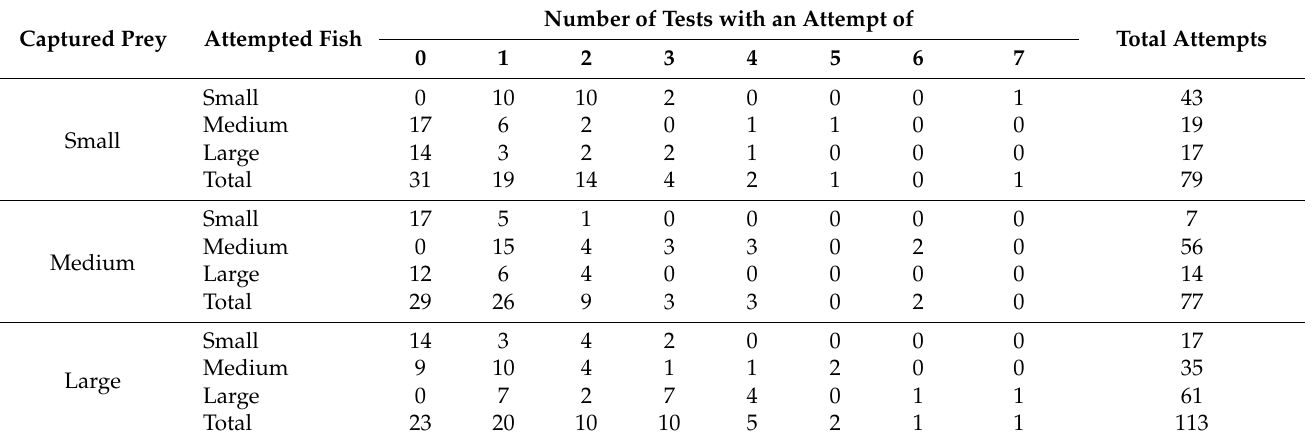
Table 3. Distribution of the number of attempts to capture prey of different sizes during successful tests according to the size of the prey